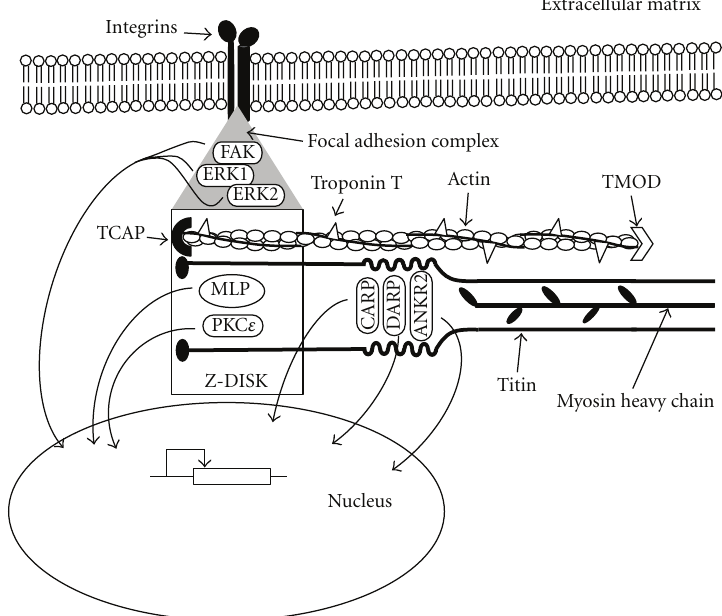
Figure 1: Schematic representation of the structures of the myofibrils responsible of contraction, sensation, and transduction of mechanical stimuli in the developing heart. Force is generated by the thick filaments formed by myosin heavy chain (amhc, MYH6, MYH7) associated with myosin regulatory (Myl7) and essential light chains and their interaction with the thin filaments, formed by actin (ACTC1, cfk) and troponin T (Tnnt2), TCAP and TMOD, amongst others. Titin spans a half of the sarcomere, from the Z-Disc (where it interacts with TCAP and MLP) to the M-band. One of its intermediate segments, the N2A-region, acts as a mechanotransducer and binds CARP, DARP, and ANKR2. The peripheral myofibrils of the cardiomyocytes are linked to integrins embedded in the cell membrane (sarcolemma) by means of the focal adhesion complexes of the costameres, formed by FAK ERK1 and ERK2, amongst others. In response to mechanical stimulation, proteins bound to titin (CARP, DARP, and ANKR2), proteins of the Z-Disc (MLP, PKC ε ), as well as FAK, ERK1, and ERK2, located to the focal adhesion complexes, translocate to the nucleus, where they interact with cardiac transcription factors to modify gene